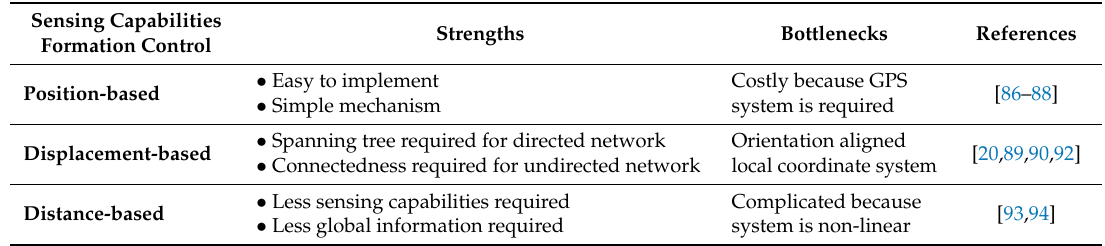
Table 4. Formation Control with respect to Sensing